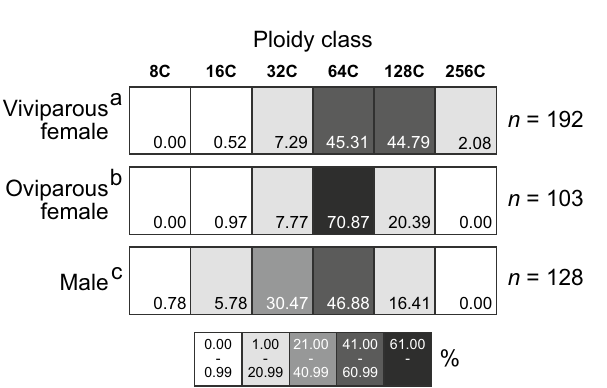
Figure 3. Ploidy analysis of aphid bacteriocytes using DAPI-fluorometry. A representative result from the analysis of adult viviparous females is presented. An image of DAPI-stained nuclei was also shown (the blue channel was extracted). Isolated nuclei of bacteriome cells were stained using DAPI, image-captured with a CCD camera, and their integrated fluorescence intensity was measured using ImageJ software. Nuclei were categorized into “bacteriocytes” or “sheath cells,” based on the size distribution of nucleolus (see “Materials and Methods”). Relative ploidy levels were calculated based on the data from head cells which are mainly diploid. Bacteriocytes of adult viviparous aphids consisted of 16C-256C cells, and 64–128 cells were dominant, while sheath cells exhibited lower ploidy levels (mainly 16C). “C” means haploid genome size, for example, 2C = diploid and 8C = octoploid.